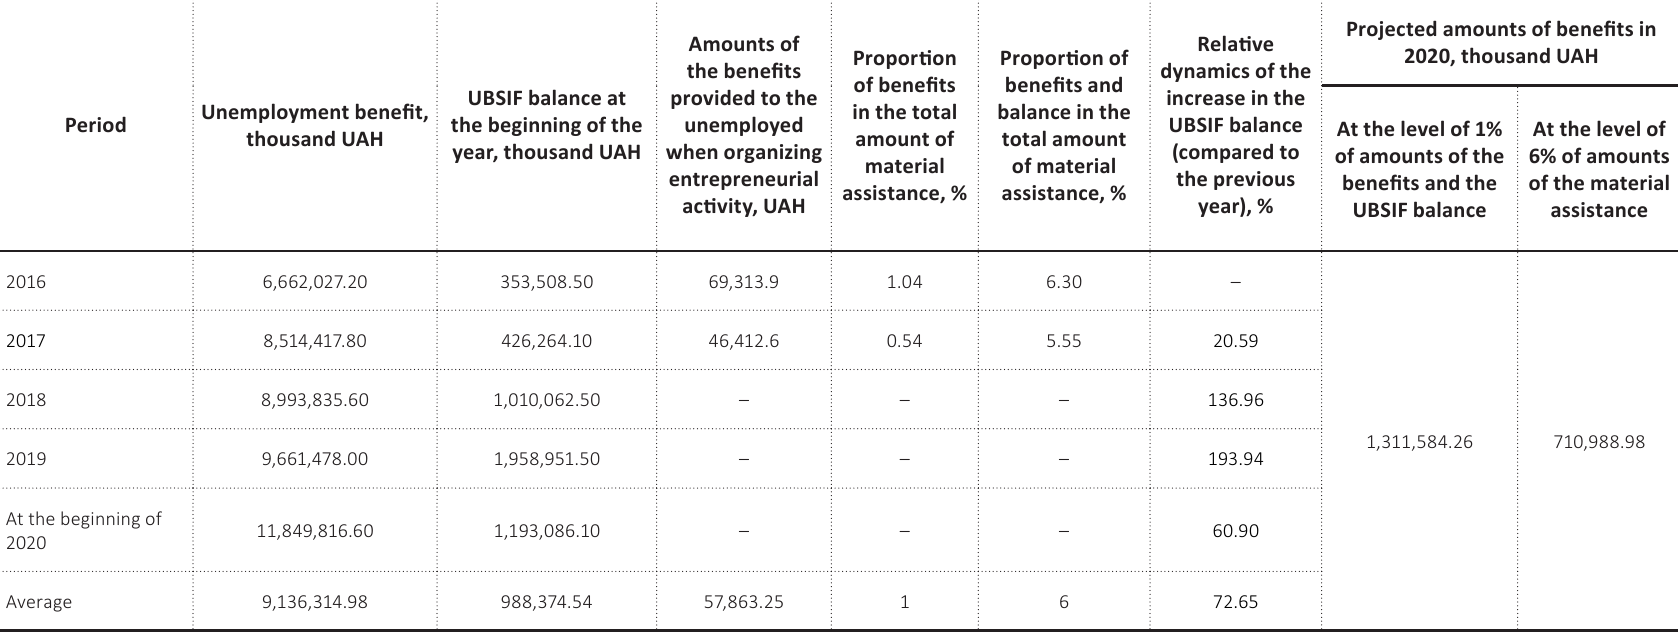
Source: The Cabinet of Ministers of Ukraine (2016, 2017, 2018, 2019a, 2019b).